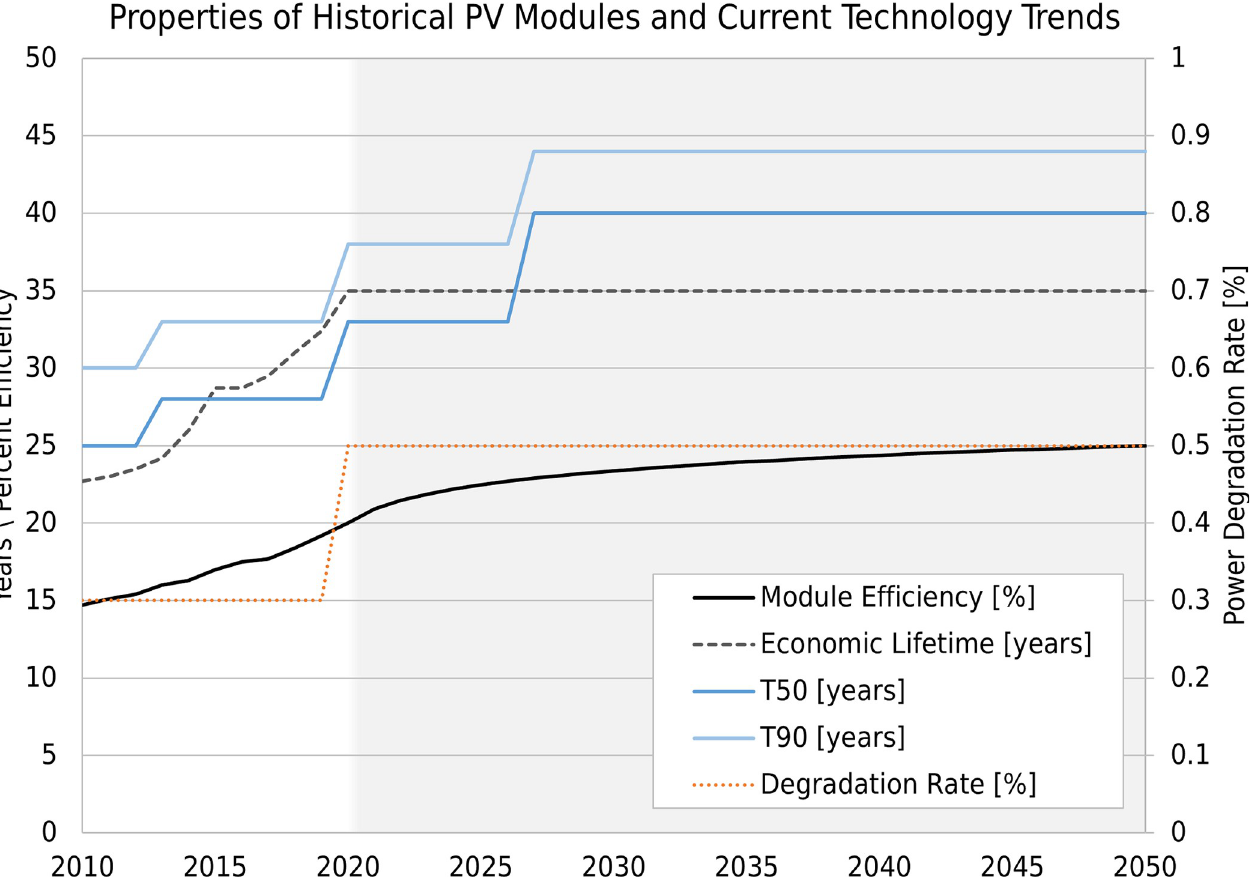
Fig 6. PV ICE Baseline properties. A selection of the dynamic module properties captured in the PV ICE baseline representing historical improvements and expected technology trends.